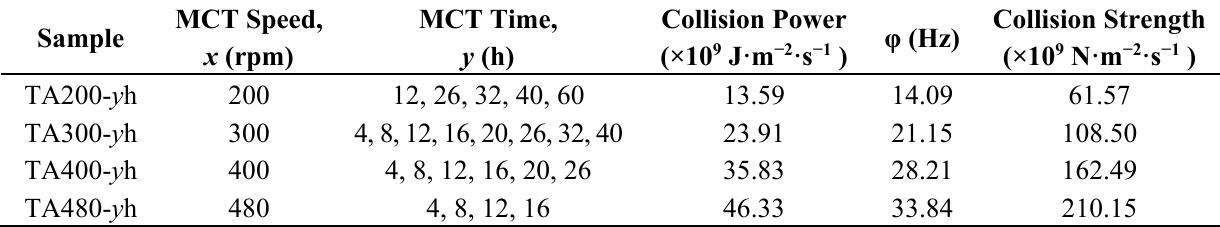
Table 3. Experimental conditions for fabricating Ti coatings by